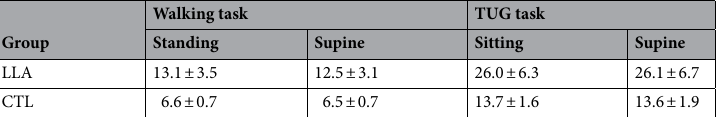
Table 2. Mean (± SD) AE times (seconds) in the LLA (n = 8) and CTL (n = 10) groups for the walking task, in the blocks where MI was performed in the standing-congruent and supine-incongruent positions; and for the TUG task, in the blocks where MI was performed in the sitting-congruent and supine-incongruent positions.